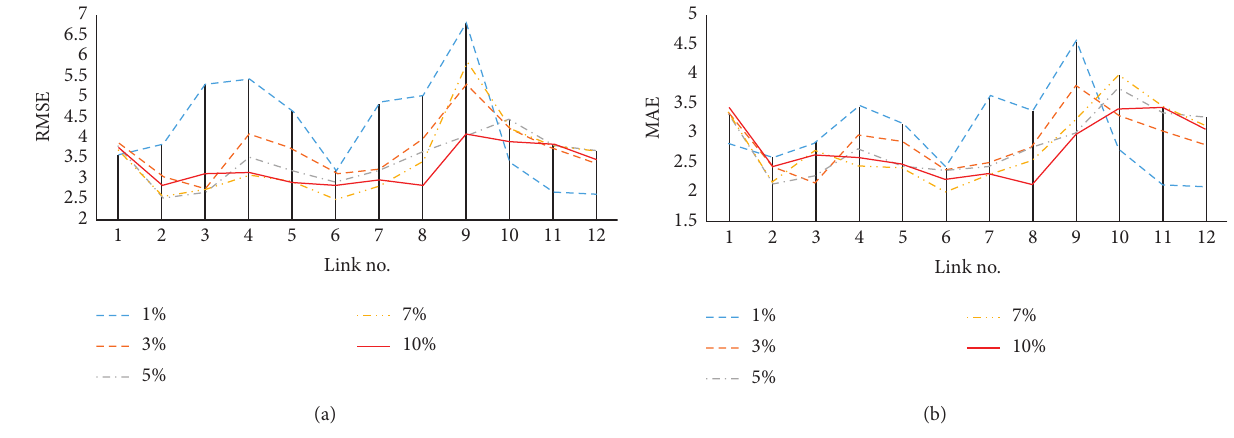
Figure 8: (a) RMSE and (b) MAE of estimated